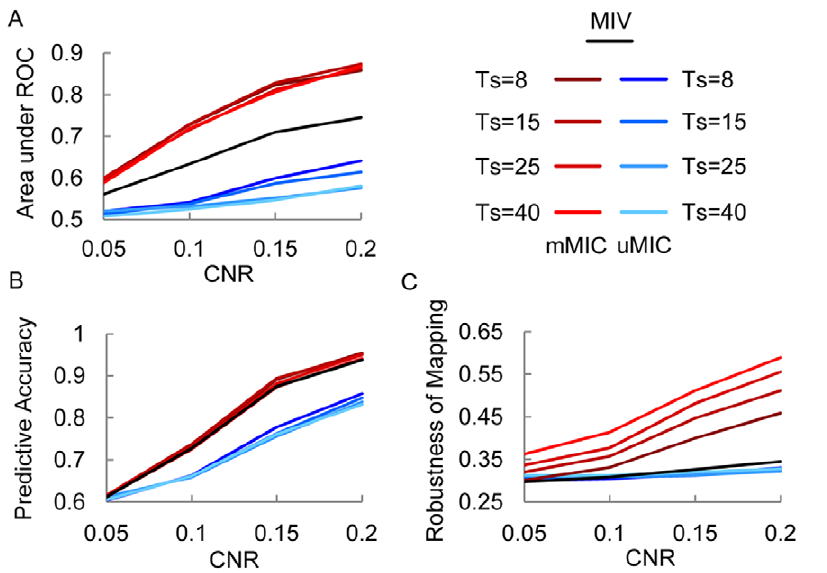
Figure 2. Performance of the MIC and the MIV in the simulated fMRI data. A) Area under ROC in the simulated fMRI data under various CNR averaged over 20 repetitions of data generation and different sizes of informative regions. B) Predictive accuracy and C) robustness of